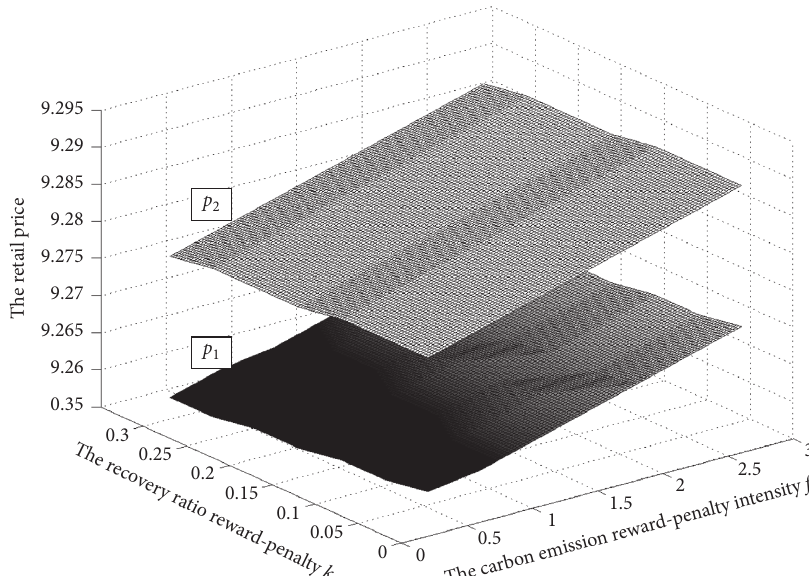
Figure 6: The retail price p